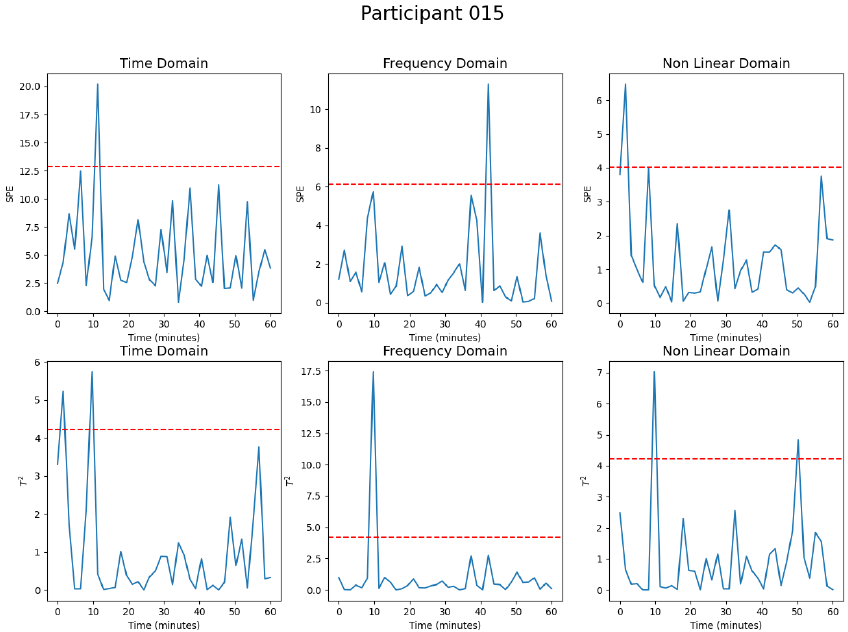
Figure 5. Participant 15 MSPC-PCA Analysis for the Heart Rate Variability.